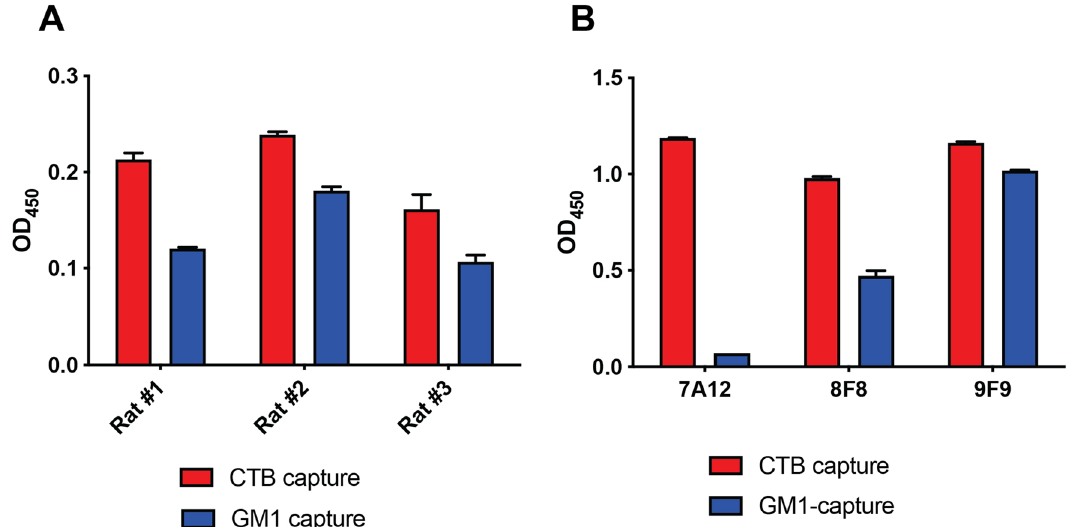
Figure 1. Generation and screening of hybridoma supernatants reacting to CTB. ( A ) Three Wistar rats were immunized with gCTB to generate a panel of mAbs and blood serum from each rat was diluted and analyzed for the level of anti-CTB IgG antibodies by antigen-capture and GM1-capture ELISA. ( B ) Characterization of three hybridomas, 7A12, 8F8 and 9F9, which showed high anti-CTB antibody levels by ELISA. The hybridoma cell culture supernatants showed distinctive binding patterns to CTB in antigen-capture vs. GM1-capture ELISA. All three hybridoma showed similarly high binding in CTB-capture ELISA. By contrast, 7A12 showed the least